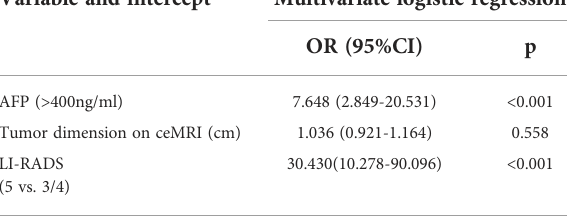
TABLE 3 Multivariate logistic regression analyses for the prediction of VEGFR2-positive HCC.